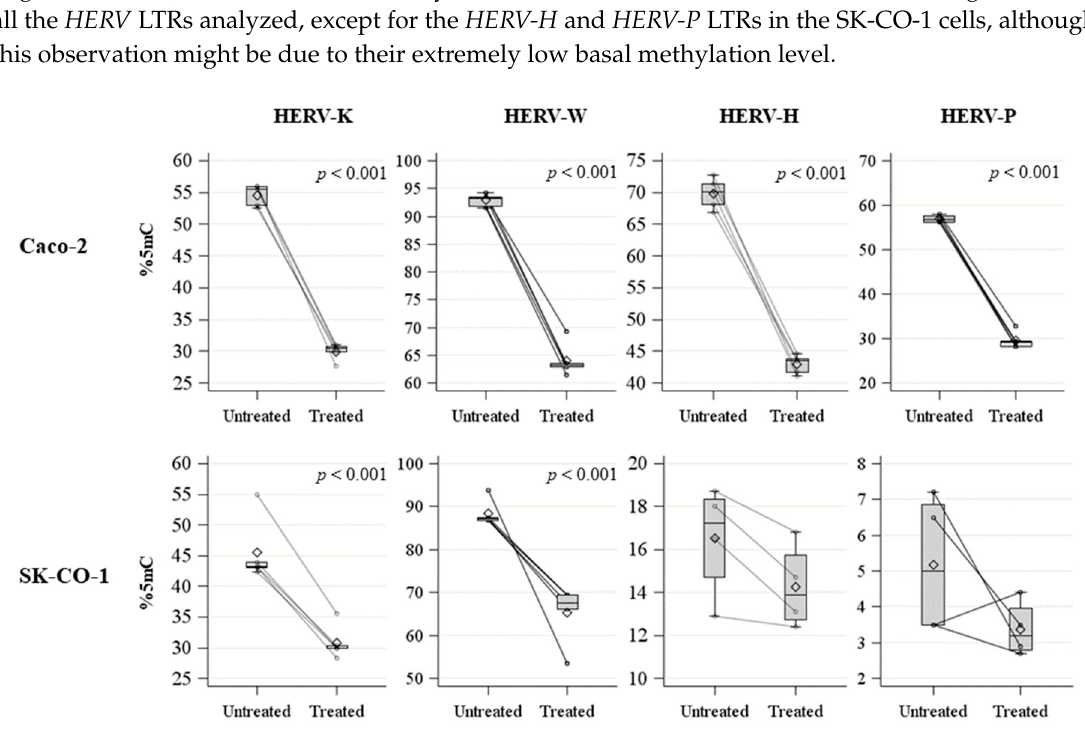
Figure 1. Spaghetti plot and box plot of HERV-H, HERV-K, HERV-W , and HERV-P LTRs methylation levels (%5mC) in untreated and treated Caco-2 and SK-CO-1 cells.